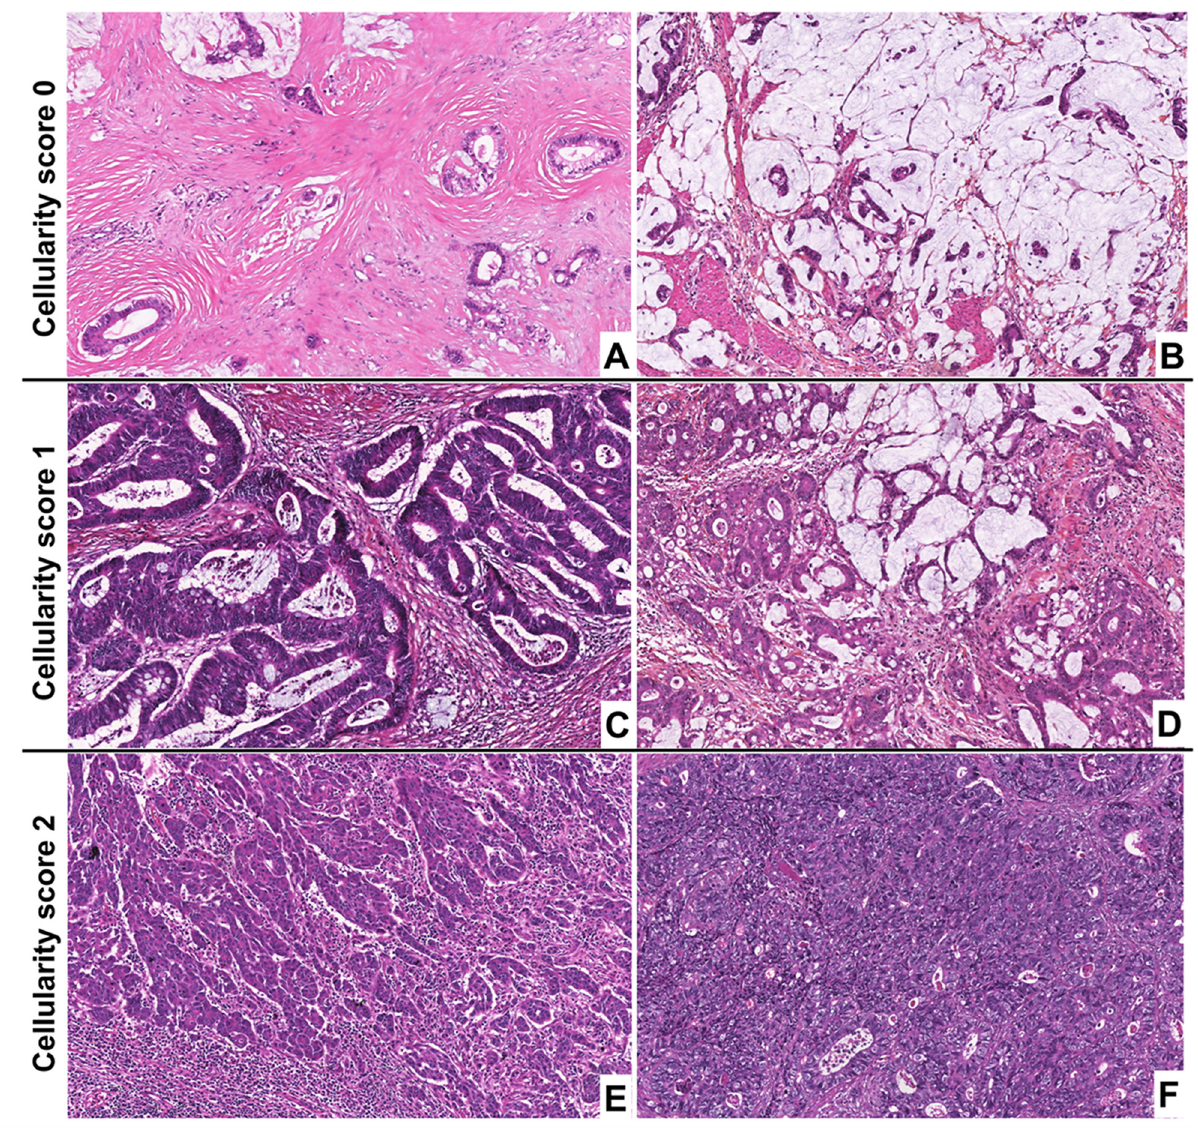
Fig 1. Illustration of the cellularity score, (Hematein-Phloxin-Saffron, x10). A-B. Cellularity score 0 in two adenocarcinomas with low cell density. C-D: Cellularity score 1 in two adenocarcinomas with moderate cell density. E-F: Cellularity score 2 in two adenocarcinomas with high cell density.